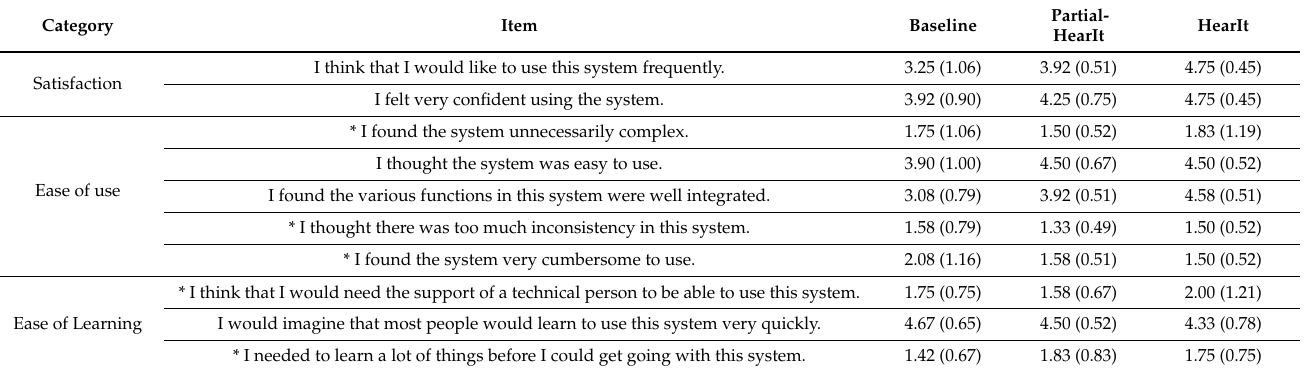
Table 2. System Usability Scale results: mean